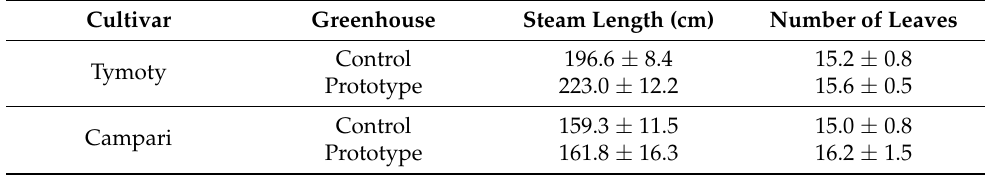
Table 2. Plant stem length and number of leaves monitored for one